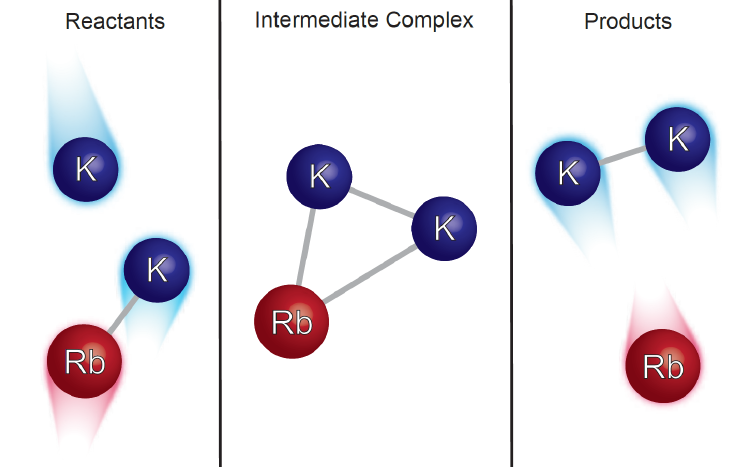
Figure 1. Possible reaction mechanisms for a colliding KRb molecule and a K atom. The chemical reaction proceeds via intermediate collisional complex to the final reaction